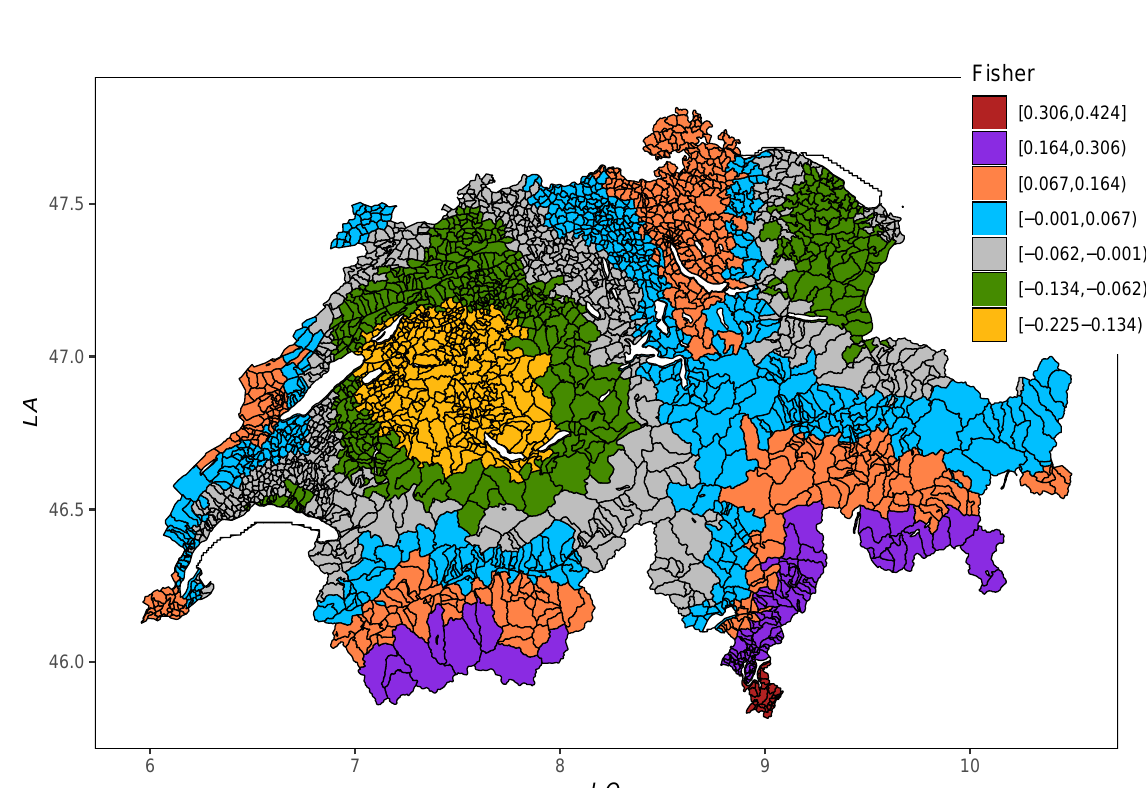
Figure 5. Illustration of the optimal classification of the spatial information along Fisher’s natural